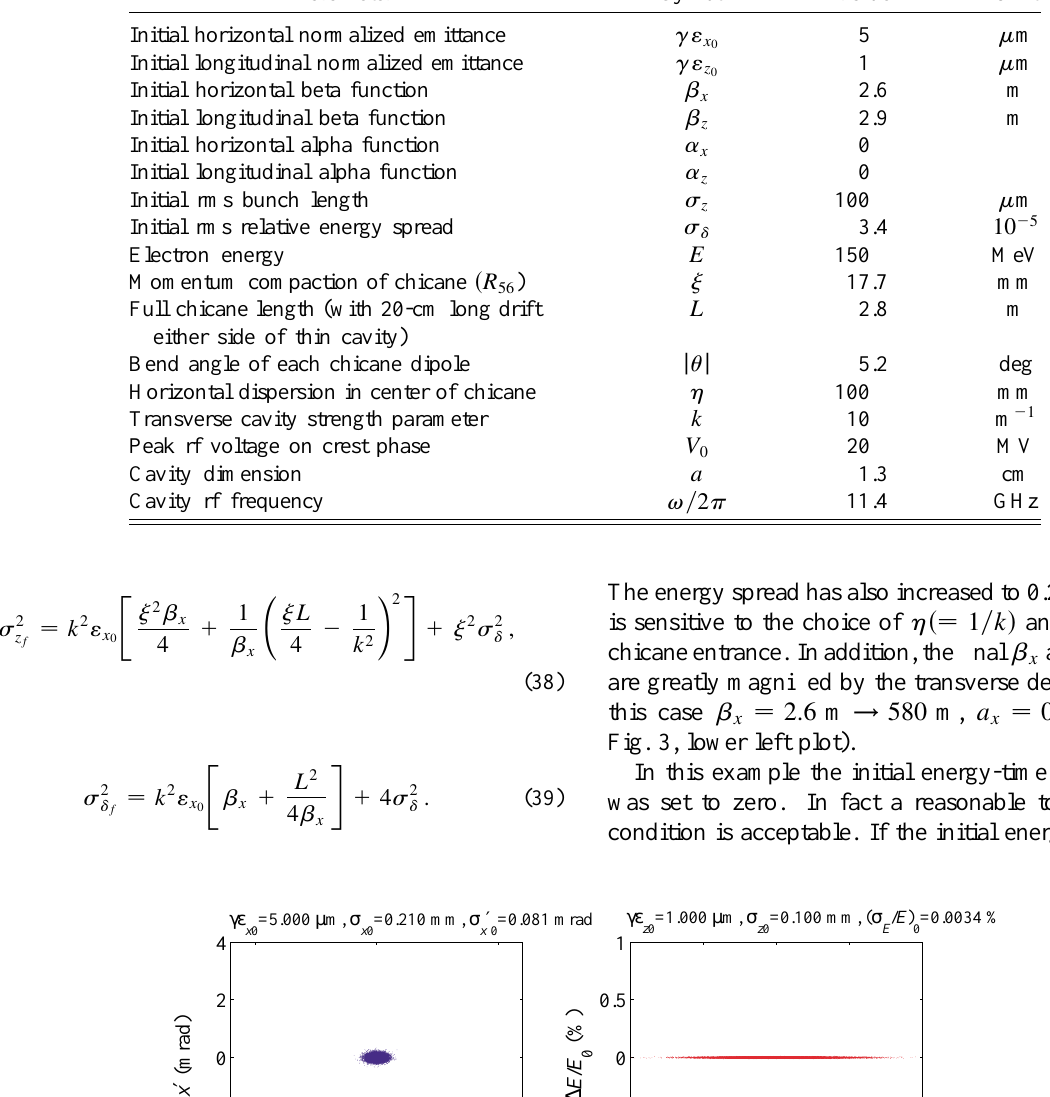
TABLE I. Beam and system parameters as an example for emittance exchange. Parameter Symbol